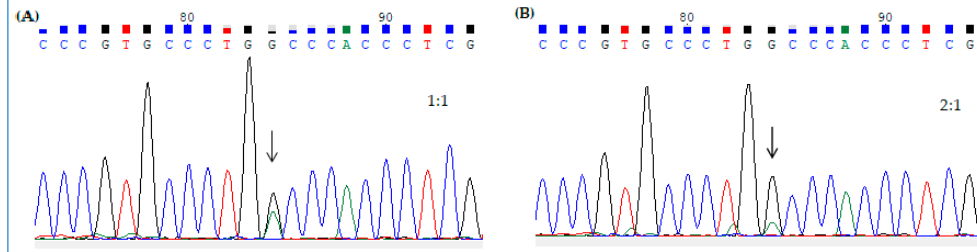
Figure 10. Electropherograms relative to H2BGFP WT/opal amplicons’ mix at 1:1 ( A ) and 2:1 ratio ( B ). The double peaks are indicated by the arrows.